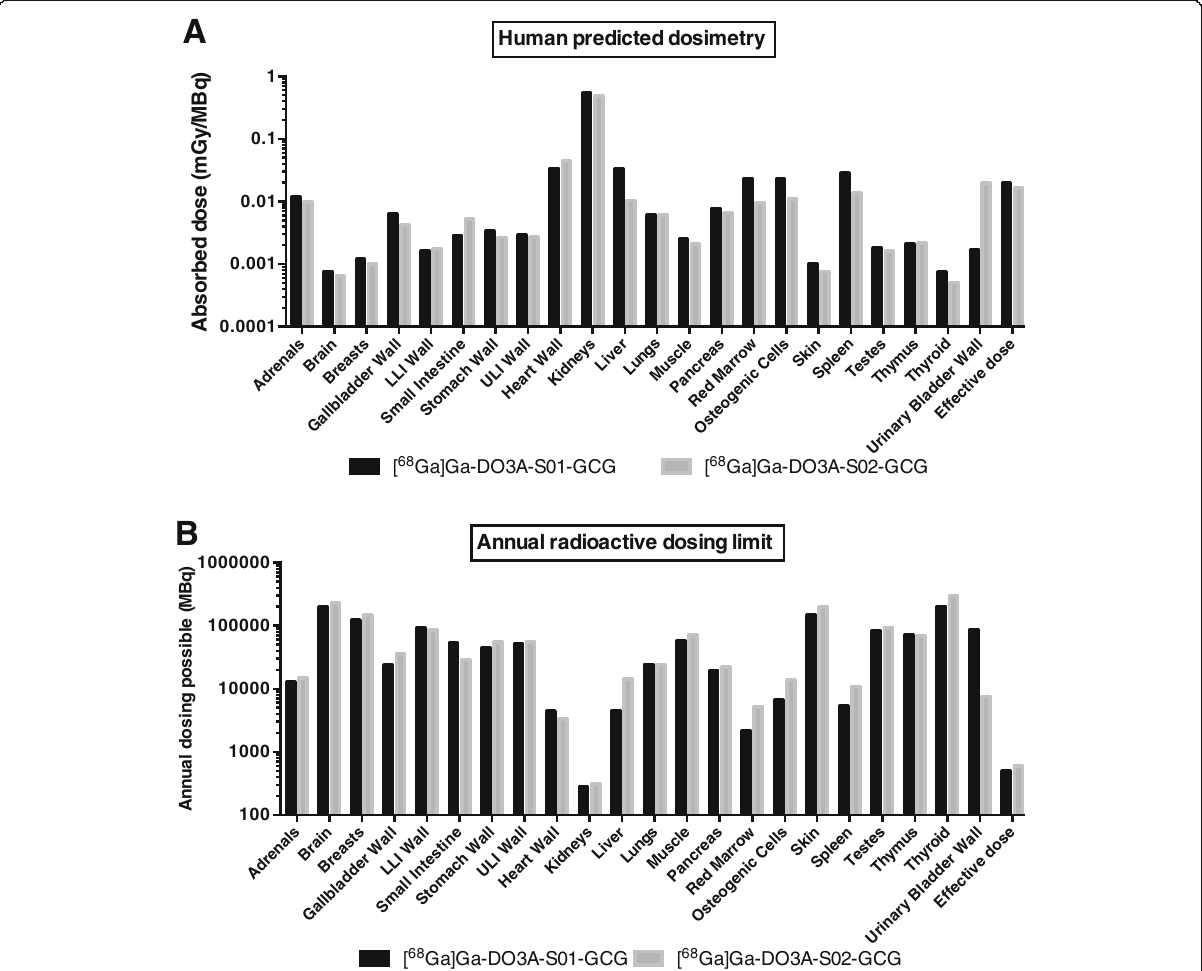
Fig. 6 Human predicted dosimetry of [ 68 Ga]Ga-DO3A-S01-GCG and [ 68 Ga]Ga-DO3A-S02-GCG. The human predicted tissue-specific-absorbed dose and whole body effective dose of [ 68 Ga]Ga-DO3A-S01-GCG and [ 68 Ga]Ga-DO3A-S02-GCG ( a ). The maximal annual radioactive dosing possible of either radiotracer, based on the absorbed dose and the annual radiation safety limits ( b ). The renal dose was limiting for both [ 68 Ga]Ga-DO3A- S01-GCG and [ 68